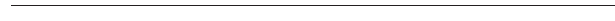
FIGURE 2 | Processing of the chimeric hairpins. (A) Expression of miR-134 and control sequences from chimeric hairpins, design 1. Left panel: 10 µg of the indicated plasmids were transfected into 4 DIV primary cortical neurons per 10 cm tissue culture dish. RNA was prepared for northern blotting at 7 DIV and assayed for the indicated miRNAs. Right panel: 1 DIV primary cortical neurons were induced with rAAV (crude lysate) carrying the indicated plasmids. RNA was extracted at 7 DIV for northern blot assaying for the indicated miRNAs. ImageJ software was used to extract expression data and the levels of miR-134 were normalized against the levels of endogenously expressed miR-138. (B,E) Expression of miR-134 from the miRNA134.1 (B) and the miRNA134.2 (E) construct. 4 DIV primary cortical neurons were transfected with 250 ng the indicated plasmids per well of a 24 well plate. At 7 DIV, RNA was harvested and qPCR analysis was performed. miR-134 levels were normalized against the levels of endogenously expressed U6 snRNA. Fold of induction is expressed relative to the miR-134 levels in cells transfected with AAV vector, which are arbitrarily set to 1. Results are shown as means + s.d. [ (B) : n = 2; (E) : n = 2]. (C,D) Expression of miR-99a and miR-134 from the miRNA99a.1 (C) and the miRNA134.2 (D) construct, respectively. HEK293 cells were transfected with 8 µg of the indicated plasmids per 10 cm cell culture dish. RNA was harvested 2 days later and subjected to northern blot analysis. Expression data were extracted using ImageJ software. miR-99a levels (C) were normalized against the levels of endogenously expressed U6